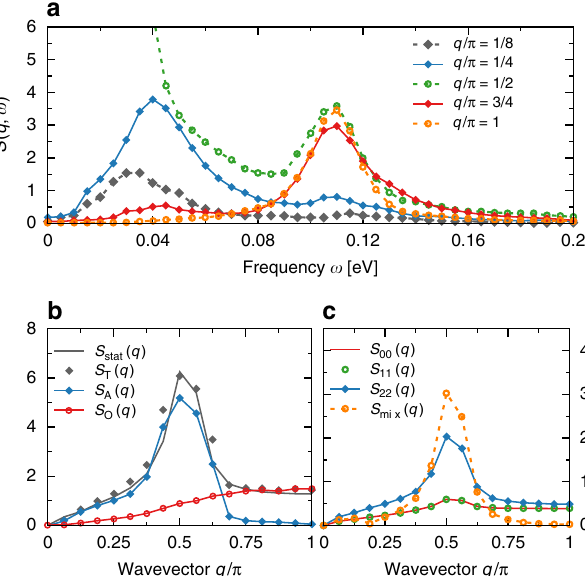
Fig. 3 Frequency and momentum dependence. a Finite momentum cuts, q / π = 1/8, 1/4, 1/2, 3/4, 1, of the dynamical SSF. b Total static SSF obtained as an expectation value in the GS j i , S stat ( q ) (black line), and also via the ω integration of the dynamical SSF, S T ( q ) (black points). In the same panel, we present also the contributions to the static SSF from acoustic and optical modes, S A ( q ) and S O ( q ), respectively. c Contribution to the static SSF S q Þ : γ = γ ′ represents the SSF component for each of the orbitals, while γγ ′ ð P S q Þ = S q Þ represents the sum of the inter-orbital contributions. γγ ′ ð γ ≠ γ ′ mix ð The system parameters are the same as in Fig. 2